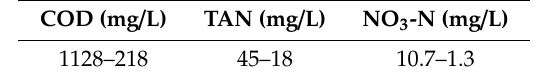
Table 3. Variation in wastewater parameters for wastewater obtained from the West Side Wastewater Treatment Facility in Fayetteville over a 1 year period. Figure 4. Percentage removal of nitrate nitrogen (NO -N) in the aerobic and anoxic tanks at 4, 8, and 3 12 h after spiking with atrazine. The total suspended solids (TSS) for the aerobic and anoxic tanks was 7029 and 6024 ± 600 mg/L, respectively.